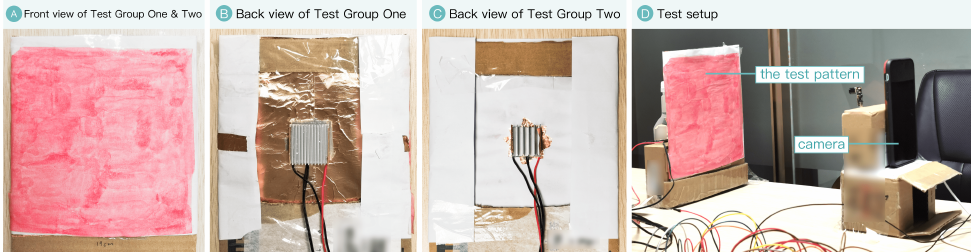
Figure 7. The group design and the setup of the thermochromic effect technical evaluation: ( A ) the thermochromic test pattern for both Test Group One and Two is a 19 × 19 cm solid-filled rectangle; ( B ) in Test Group One, the thermally conductive layer is a 19 × 19 cm rectangle, and the Peltier element varies at 2 × 2 cm, 3 × 3 cm, and 4 × 4 cm; ( C ) in Test Group Two, the thermally conductive layer is a flower-shaped area within a diameter of 5.7 cm, and the Peltier element is at 3 × 3 cm; ( D ) the setup of the hardware